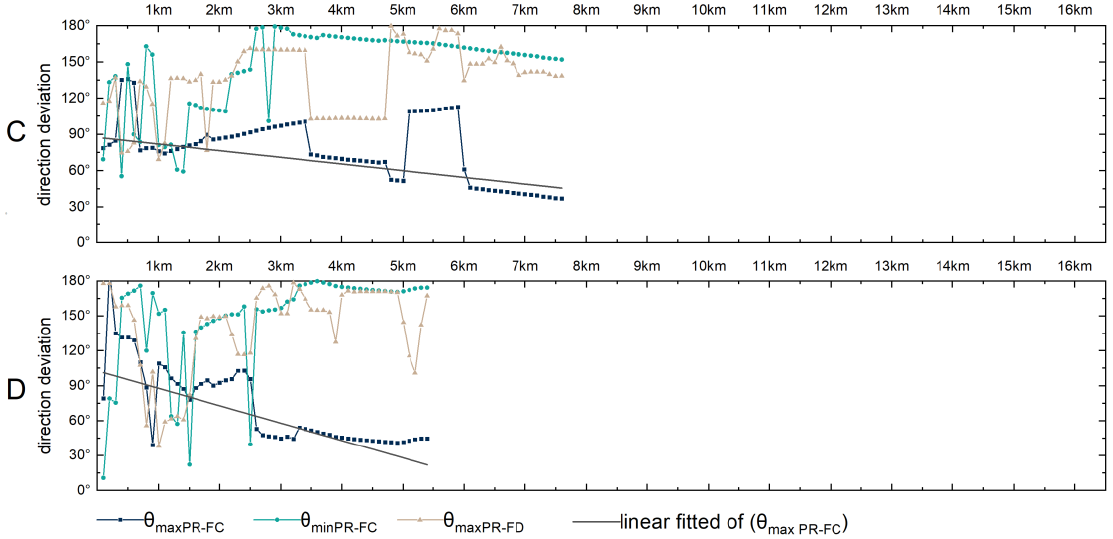
Water 2021 , 13 , x FOR PEER REVIEW Figure 6. Influences of rainfall movement direction (RMD) and the direction of river confluence on the peak runoff. ( A ) Dasha River. ( B ) Buji River. ( C ) Xinzhou River. ( D ) Futian River.